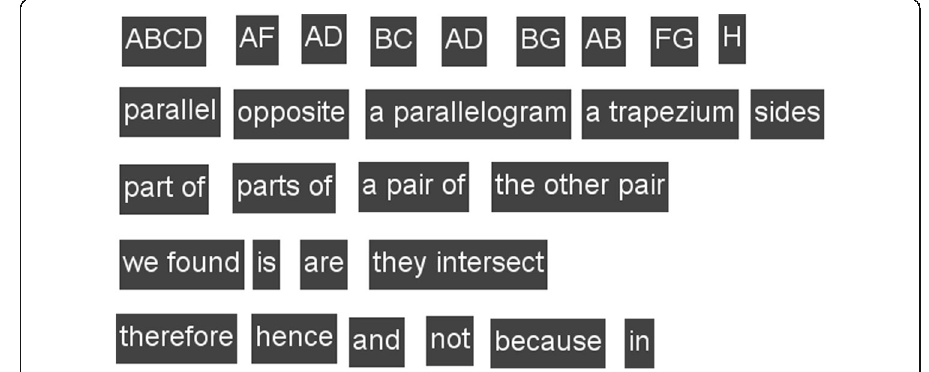
Fig. 7 Geometrical problem in Haj-Yahya et al. (2014)